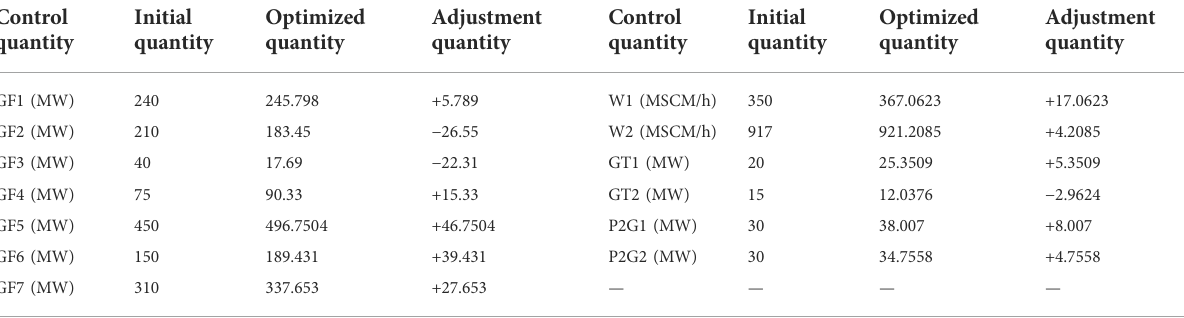
TABLE 3 Adjustment of control quantity using the optimization strategy proposed in this paper.